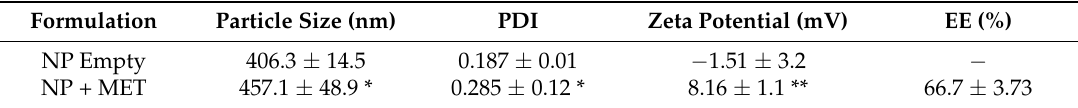
Figure 1. Atomic force microscope (AFM) 2D and 3D images. ( A ) Free drug nanoparticles and ( B ) MET-loaded PLGA (metformin-loaded poly lactic- co -glycolic acid) nanoparticles. The topography was observed in water with a frequency shift of 1 Hz and a cantilever oscillation amplitude of 2 µm × 2 µm. The scale indicates the topographic height. Table 1. Loading efficiency of metformin-loaded PLGA (metformin-loaded poly lactic- co -glycolic acid) nanoparticles by double emulsification.